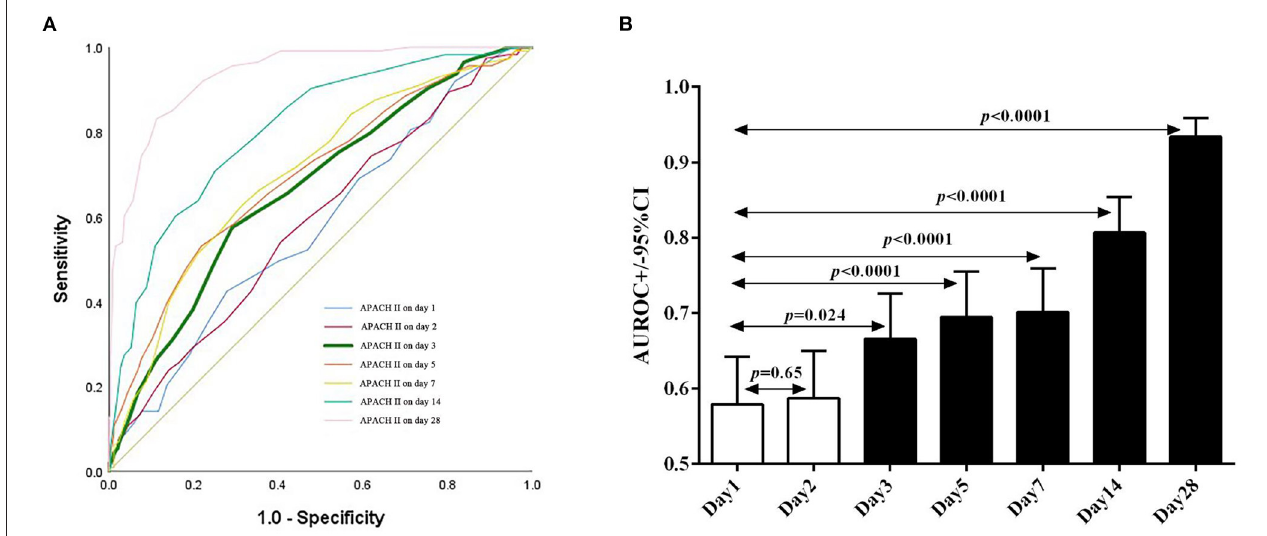
FIGURE 3 | Sequential APACHE II score as predictors of the hospital mortality of patients. (A) The receiver operating characteristic (ROC) curves of APACHE II score on days 1, 2, 3, 5, 7, 14, and 28 after admission to ICU. (B) The AUROC of APACHE II score on days 2, 3, 5, 7, 14, and 28 is compared to that of day 1.